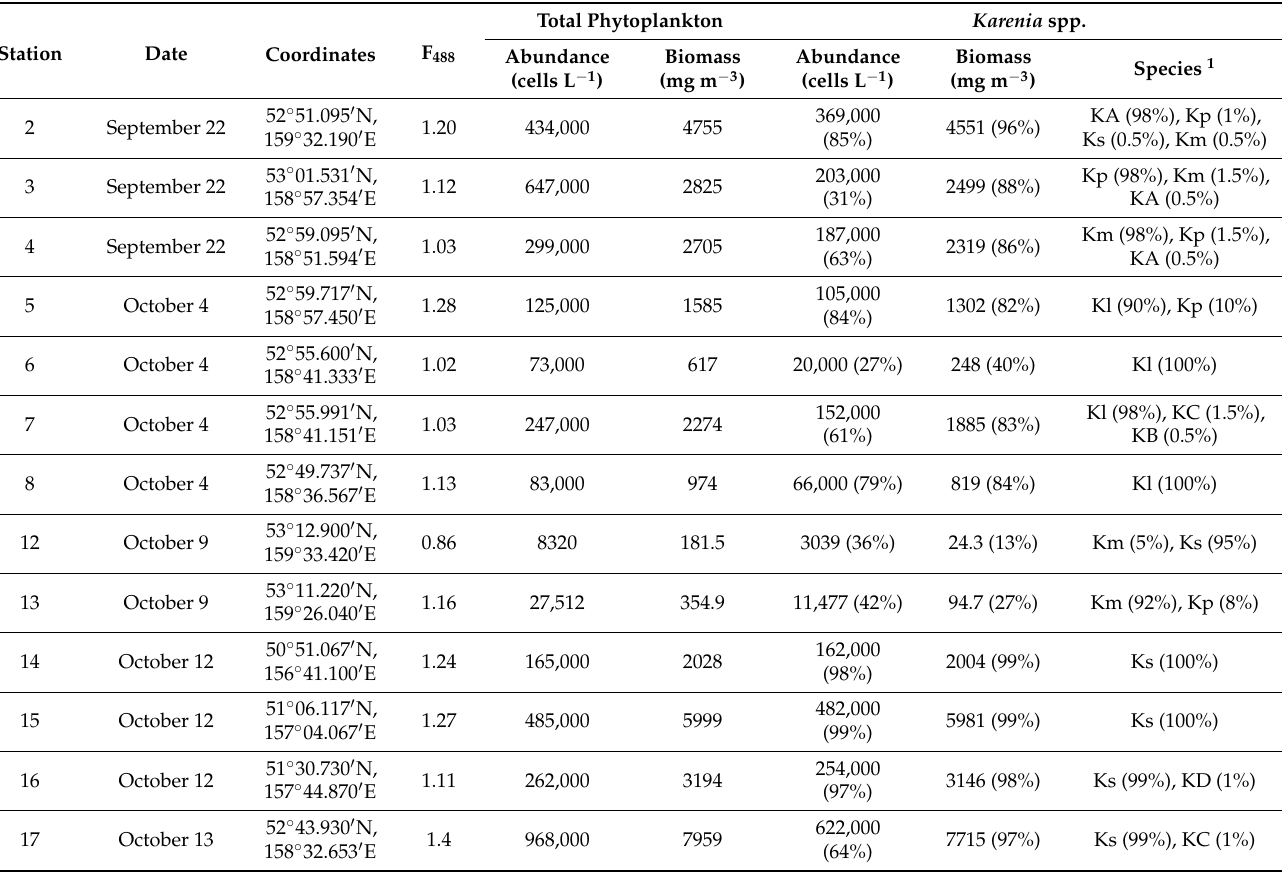
Table 1. Sampling stations (1 m level). Abundance and biomass of total phytoplankton and percentage of Karenia spp. ones off the east coast of Kamchatka in autumn